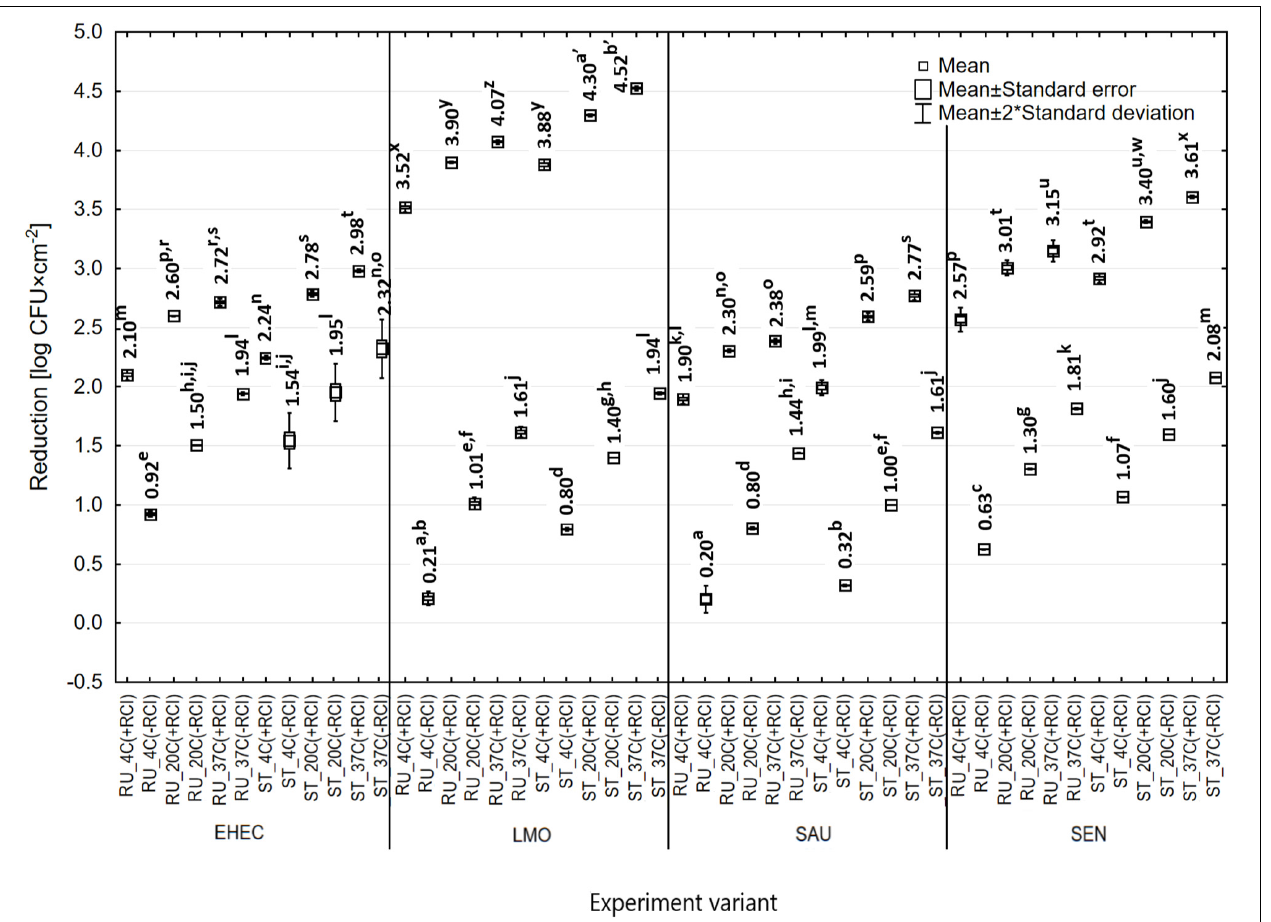
FIGURE 7 | Reduction in the number of bacteria under the influence of RCI depending on the temperature [RU – rubber, ST – stainless steel; a, b, c – values marked with different letters are significantly different ( P < 0.05); EHEC – E. coli O157:H7; LMO – L. monocytogenes ; SAU – S. aureus ; SEN – S .